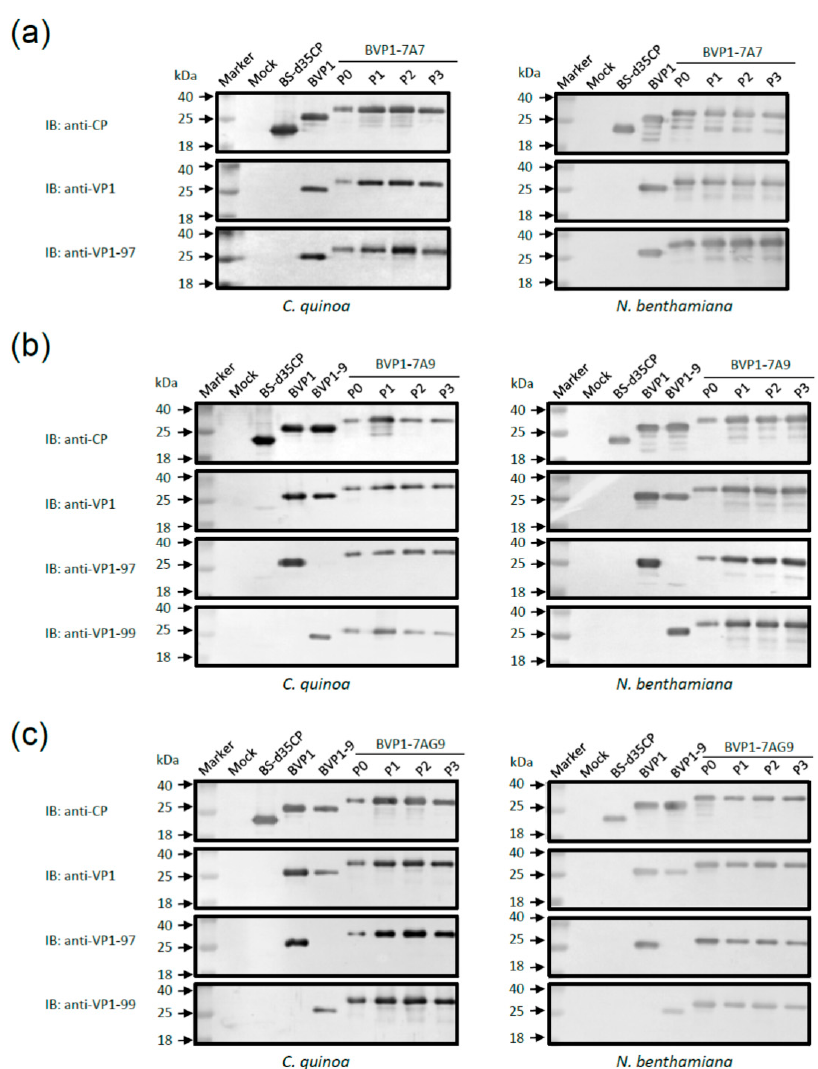
Figure 6. Stability analysis of the chimeric BVP1s over sequential passages in C. quinoa or N. ben- thamiana plants by SDS-PAGE immunoblot. C. quinoa (left panel) or N. benthamiana leaves (right panel) were inoculated with H 2 O (mock) or with recombinant plasmids pBS-d35CP, pBVP1, pBVP1-9, pBVP1-7A7, pBVP1-7A9, or pBVP1-7AG9, respectively. BVP1s P0 represents the initial inoculation with the plasmid DNA as inoculums, whereas P1 to P3 stands for the first to third passage using crude leaf sap from P0 as inocula, respectively. Total proteins extracted from leaves inoculated with pBVP1-7A7 ( a ), pBVP1-7A9 ( b ), or pBVP1-7AG9 ( c ) leaves were separated using 12% SDS-PAGE. The proteins were transferred to PVDF membranes and reacted with antisera against BaMV CP (anti-CP), FMDV VP1 (anti-VP1), FMDV VP1 (O/TAW/97 specificity, anti-VP1-97), or FMDV VP1 (O/TAW/99 specificity, anti-VP1-99), respectively. The relative molecular weights (in kDa) are given on the left of each panel. IB, immunoblot.